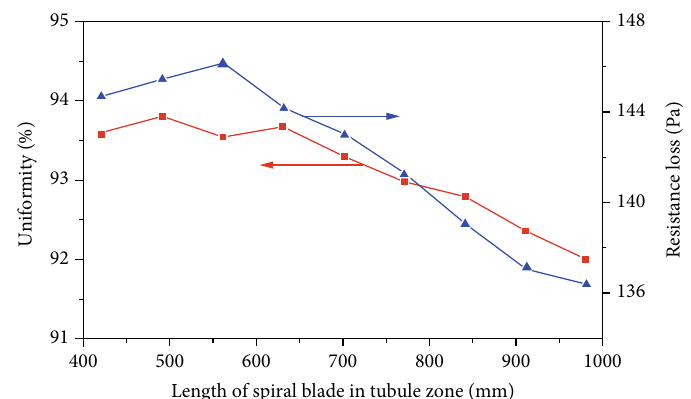
Figure 12: In fl uence of spiral blade length on fl ow parameters in tubule zone.